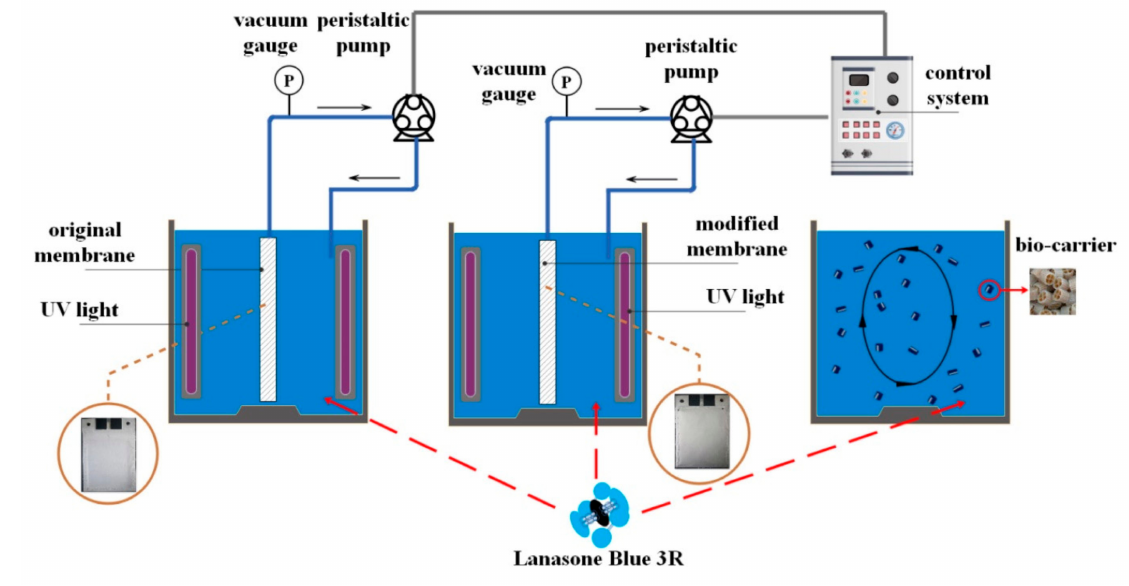
Figure 2. Schematic diagram of the cross-flow membrane filtration system